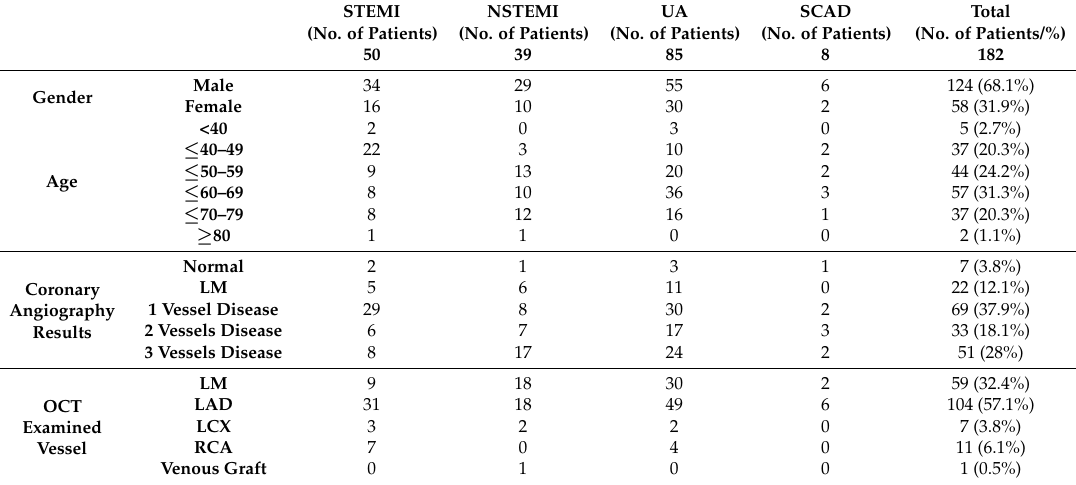
Table 2. Demographic, clinical and angiographic data of patients investigated by OCT (LAD—left anterior descending artery, LCX—left circumflex artery, LM—left main, RCA—right coronary artery).